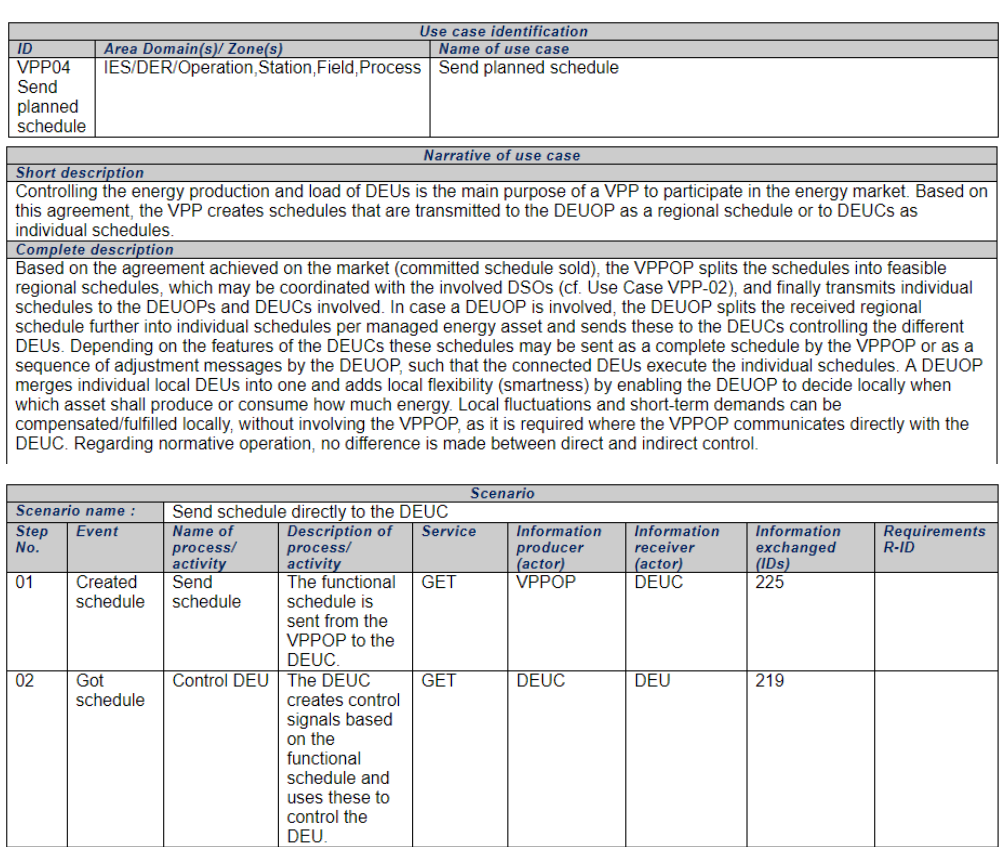
Figure 8. A Use Case Template excerpt showing three parts: ( top ) Use Case identifier, relations, and name, ( middle ) narrative definition of the Use Case, and ( bottom ) interaction steps and their